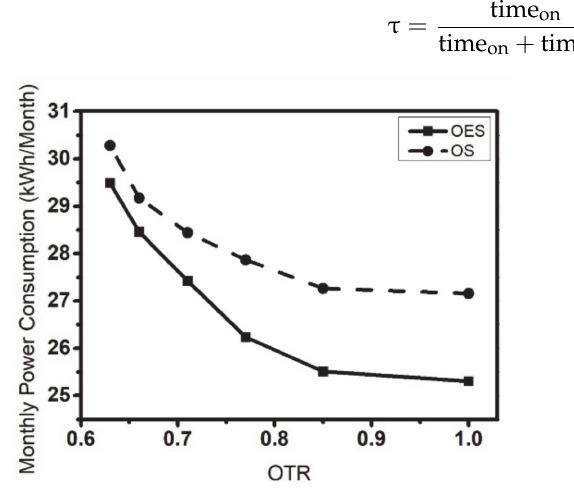
Figure 4. Monthly power consumption with varying